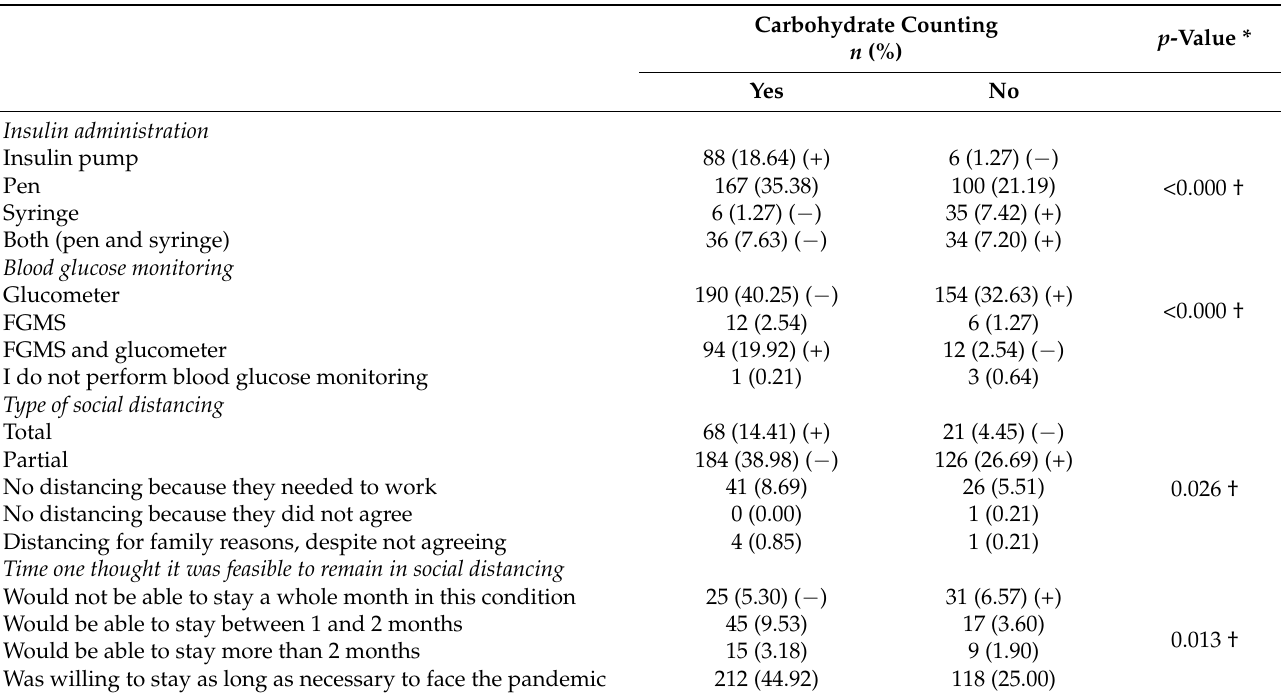
Table 2. Association between adherence to the CC strategy and insulin administration, blood glucose measurement, and social distance from individuals with T1DM during social distancing in Brazil,